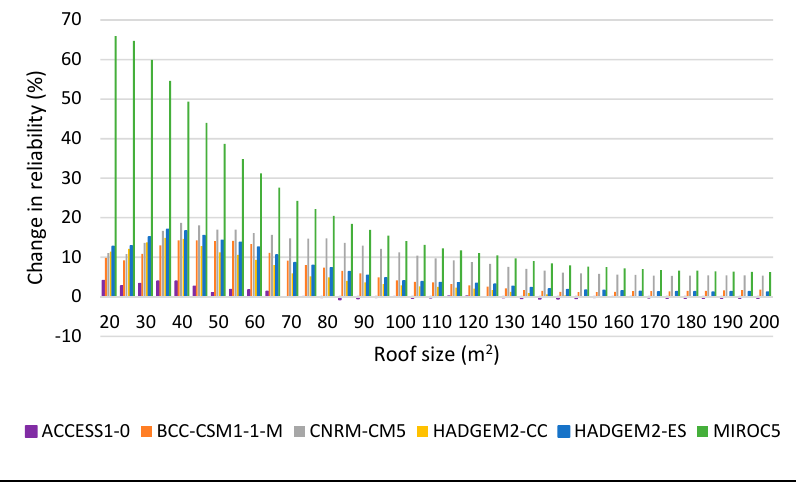
Figure 19. JJA showing change in reliability for 2060–2090 period for 5 m 3 .